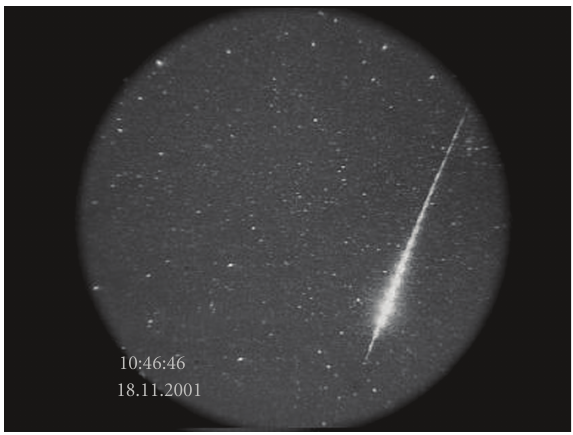
Figure 3: Composite image of bright Leonid meteor recorded by the video camera on November 18th, 2001 during the Leonid meteor